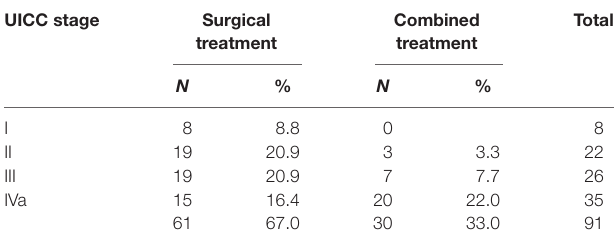
Table 1 | Patient characteristics. Table 2 | Treatment